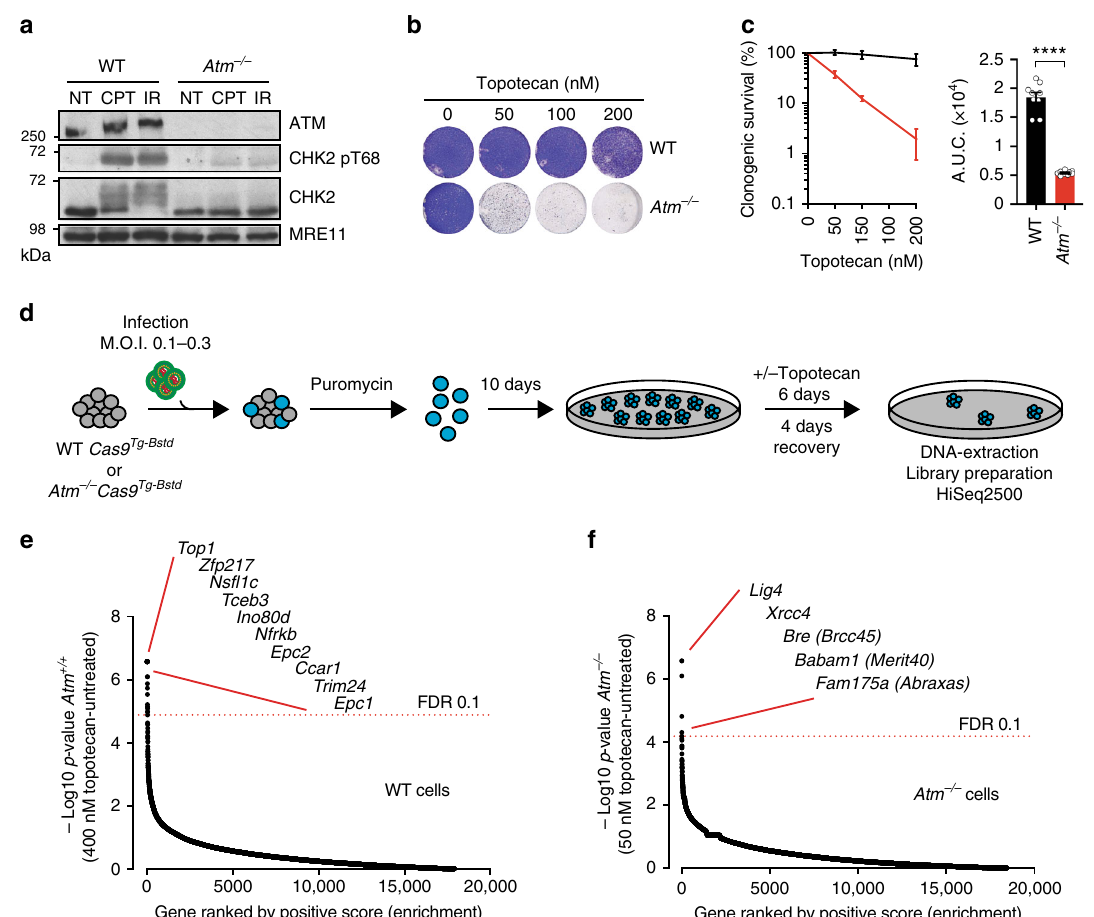
Fig. 1 CRISPR-Cas9 screening in WT and ATM-de fi cient mESCs. a Representative immunoblot images show the absence of ATM protein and defective signaling through phosphorylation of its substrate CHK2 on Thr-68. NT untreated, CPT camptothecin (1 μ M, 1 h), IR ionizing radiation (10 Gy, 1